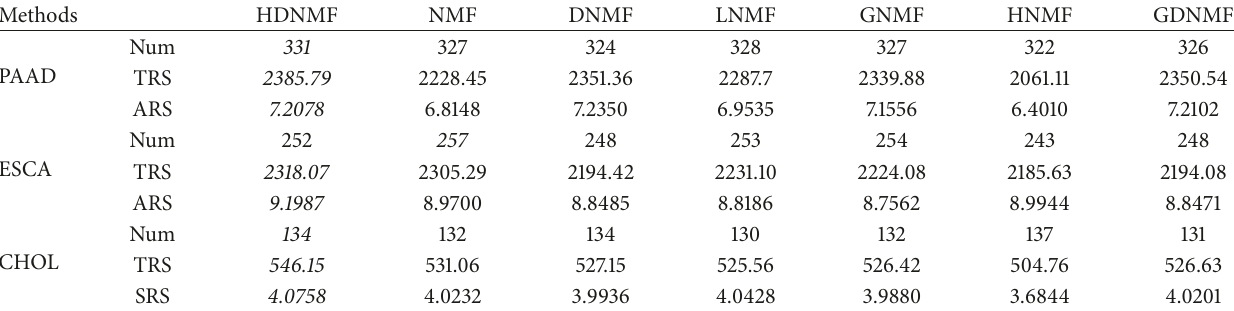
Table 5: NUM, TRS, and ARS of five methods (INTA 1).